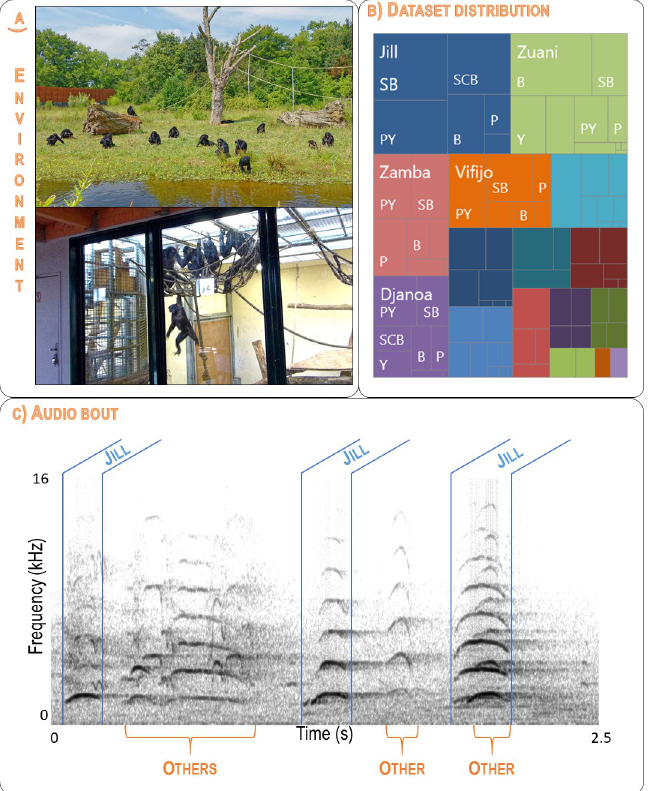
Fig 2. An example of a SUNG bioacoustic dataset: recordings of bonobo calls in social contexts. A. Each individual can be recorded in outdoor enclosures and inside buildings. B. The number of calls varies between individuals (unbalanced distribution coded by colored rectangles) and call types (coded by internal rectangles for each individual). The five most-represented individuals are named. The four least represented individuals are not shown on the chart. The detailed breakdown is given in Table 1. C. Spectrogram of a typical recorded bout (2.5 seconds extracted from the Jill698 recording) showing the difficulty of isolating good quality calls. A sequence of three Soft Barks produced by Jill can be identified (sections delimited by blue boundaries). Other individuals vocalize in the background (sections marked with orange curly brackets). Jill’s third call is not analyzed as it overlaps too much with other vocalizations. The Jil698 recording is available as S1 Sound and described in S4 Text. Photo credits: F. Levre´ro (Top) & F. Pellegrino (Bottom).